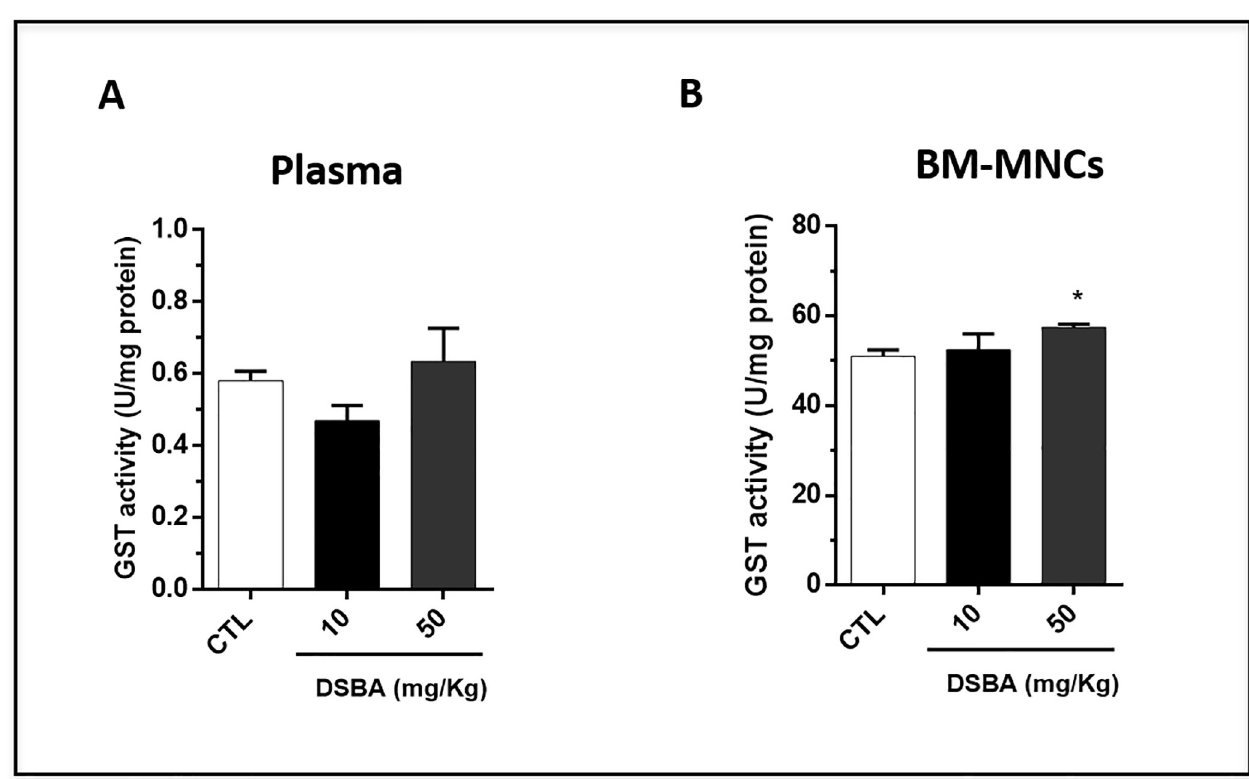
Fig 4. GST activity in C57 BL/6 mouse plasma (A) and BM-MNCs (B) after DSBA treatment. GST activity in plasma and BM-MNCs was measured at 24 h after DSBA treatment using the approaches as described in the methods section. Data are presented as mean +/- SD of three biological replicates (n = 3 mice) and analyzed by t-test: � p <